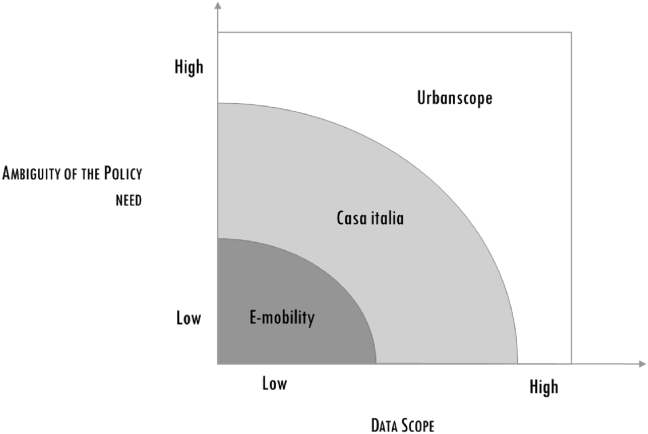
Case heterogeneity.